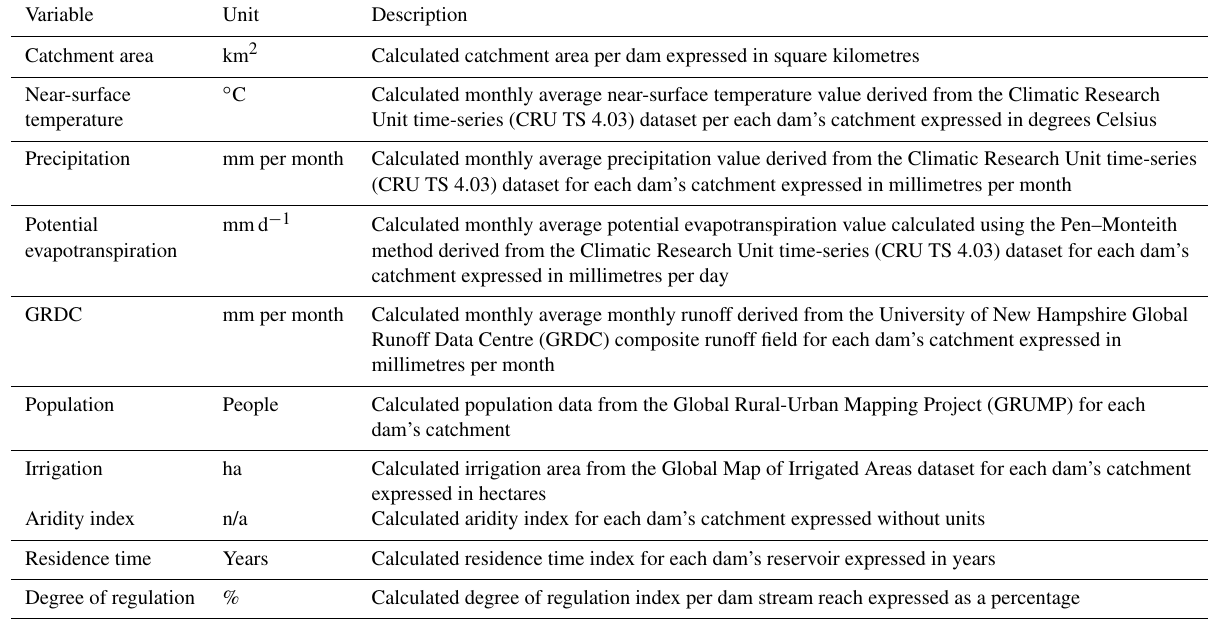
Table 4. List of hydrological and additional information processed in this study.